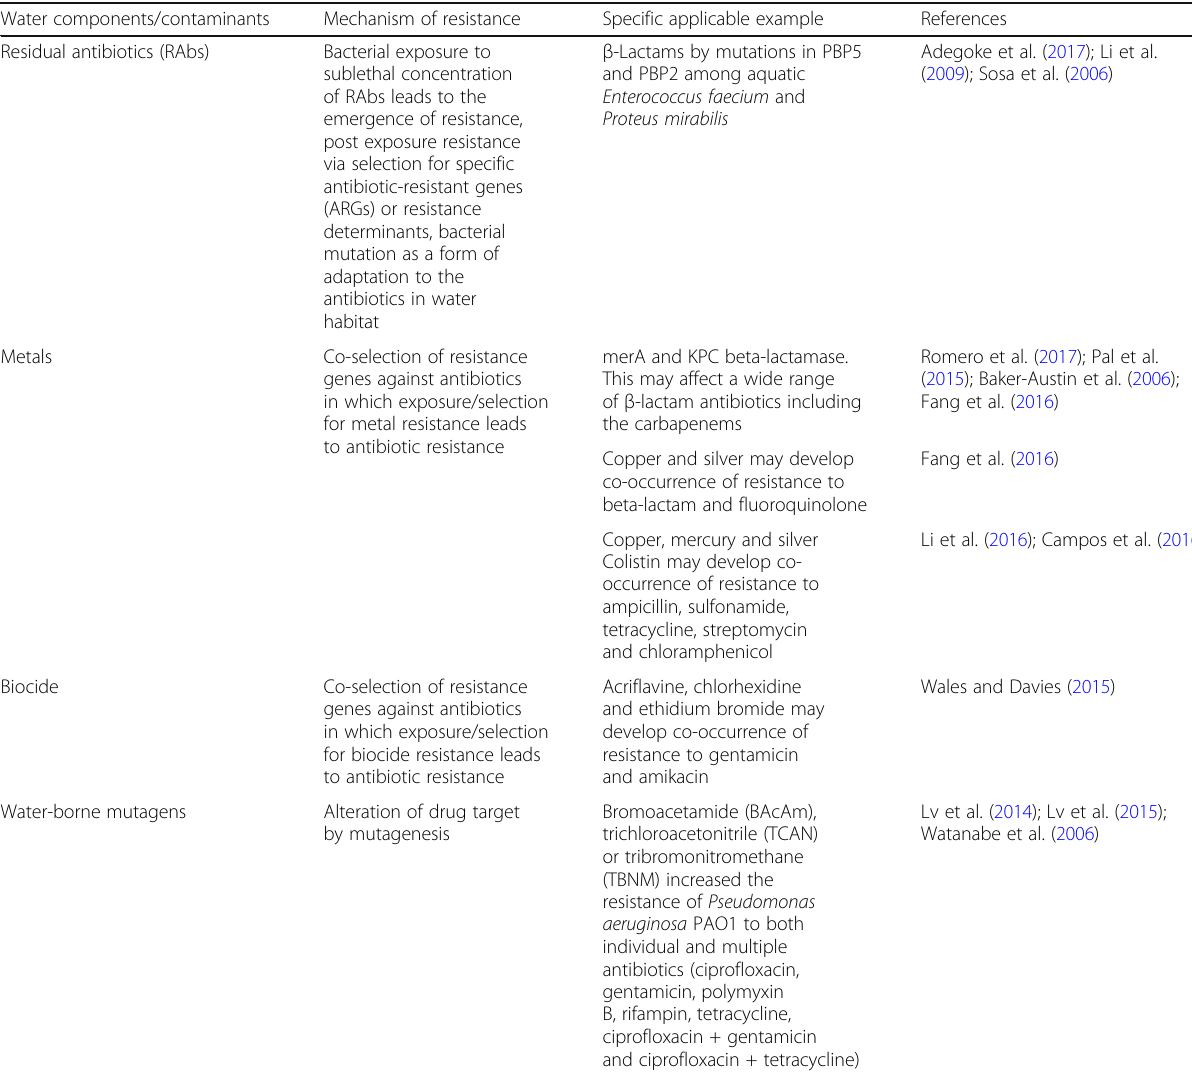
Table 1 Factors favouring the emergence of antibiotic resistance in the water